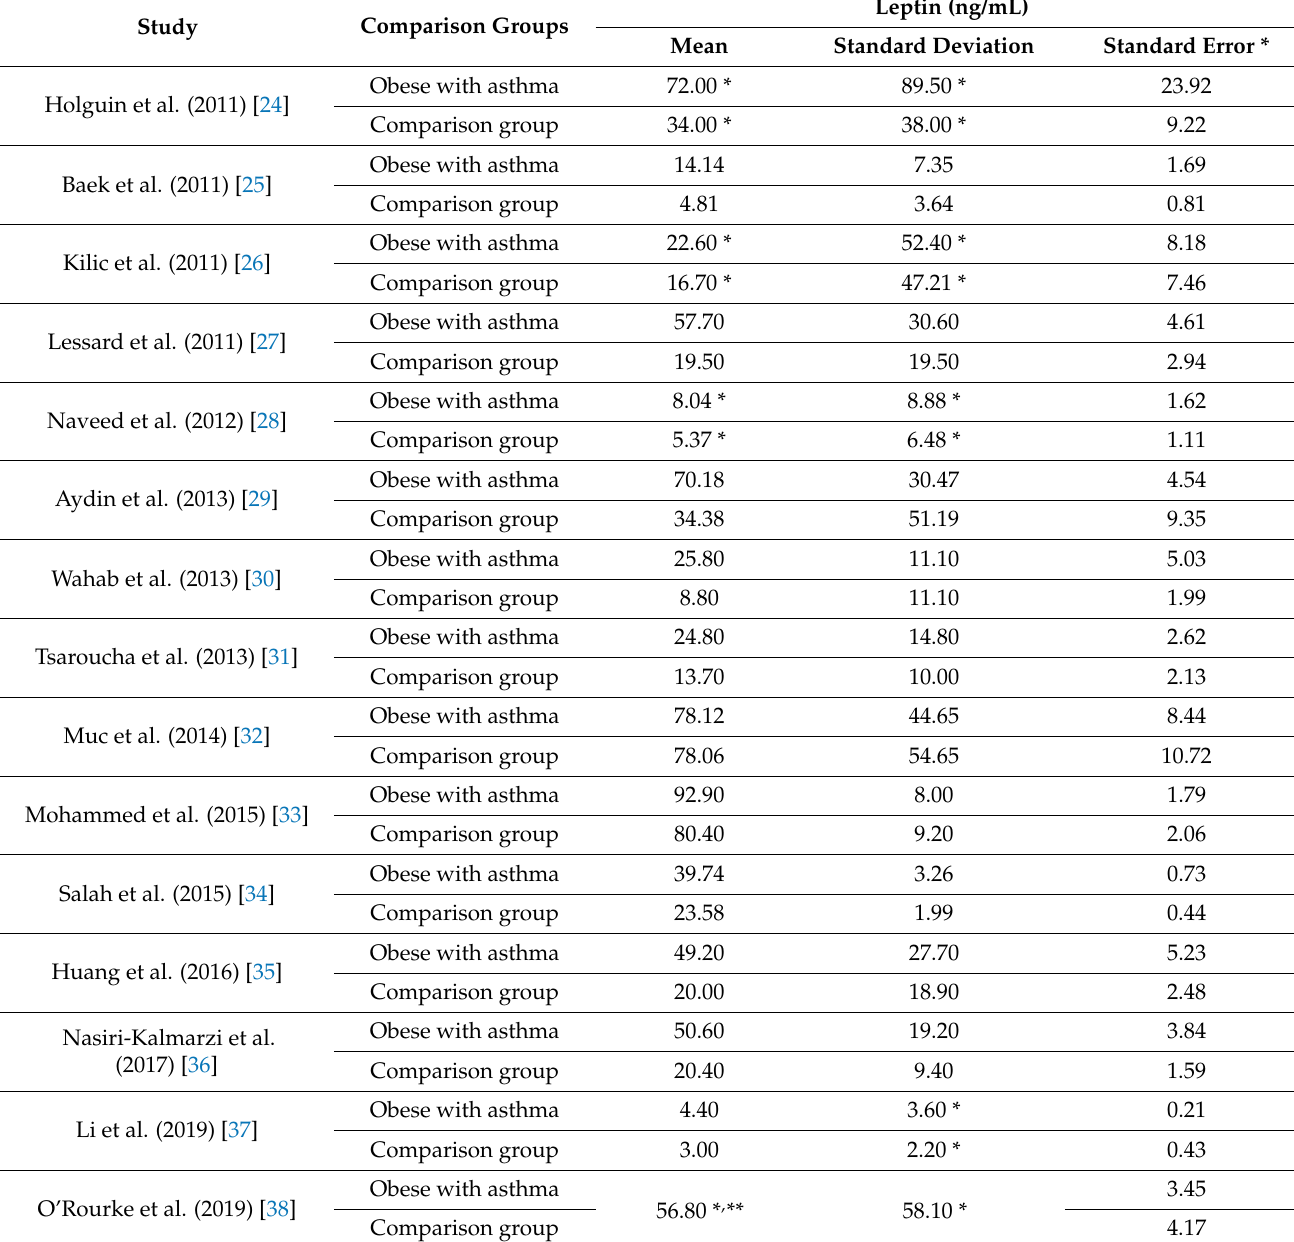
Table 2. Serum leptin data (ng/mL) used to perform the meta-analysis. * Data from the study were recalculated to obtain mean, standard deviation and/or standard error. ** This study did not calculate serum leptin levels for every group of